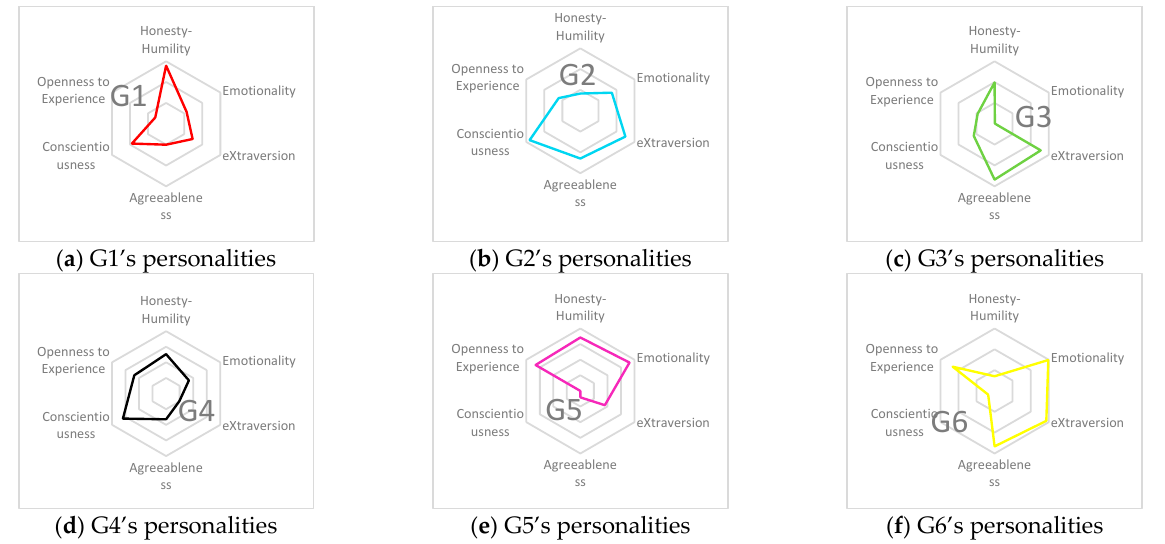
personality traits (HEXACO), we could better understand the finding that players of